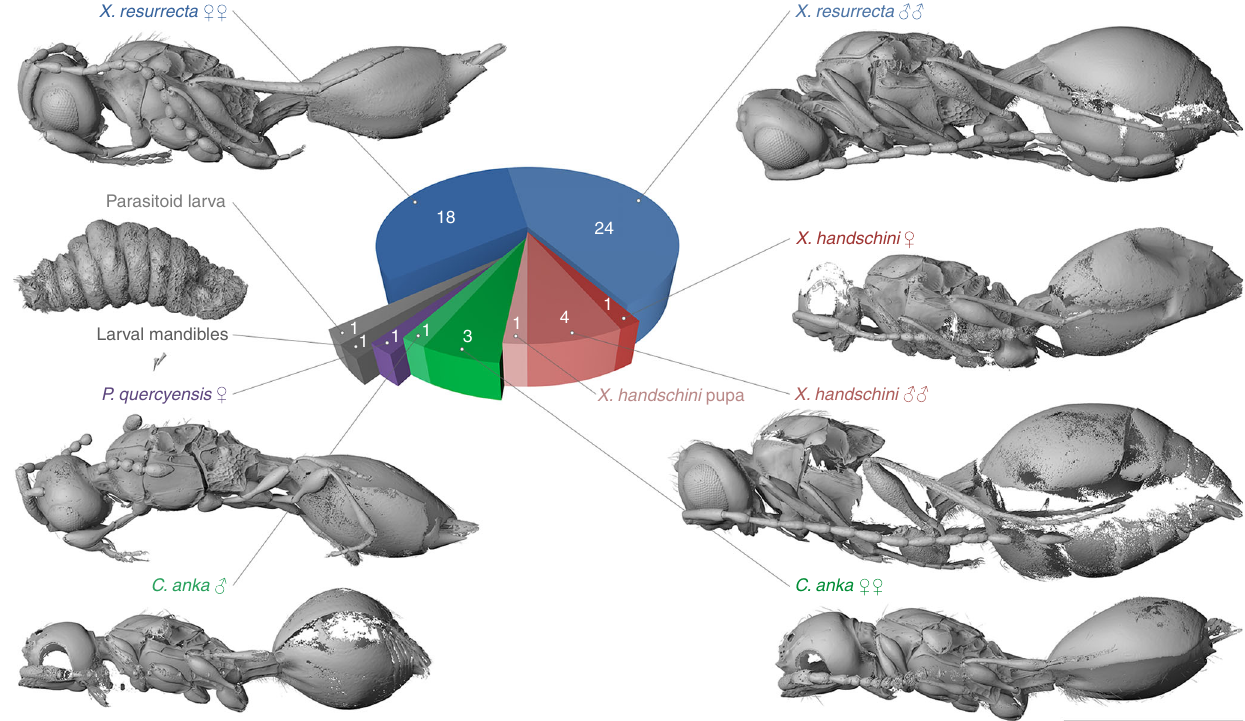
Fig. 2 Visualization and frequency of the four parasitoid species. A total number of 55 parasitation events were recognized. Xenomorphia resurrecta dominated with 18 females and 24 males. Xenomorphia handschini was represented by one female, three males, and one pupa of undetermined sex (not displayed), Coptera anka by three females and one male and Palaeortona quercyensis by a single female. Additionally, a single unidenti fi ed putative second instar larva and a set of last larval instar mandibles presumably left behind by an emerged parasitoid were identi fi ed. Scale bar: 1